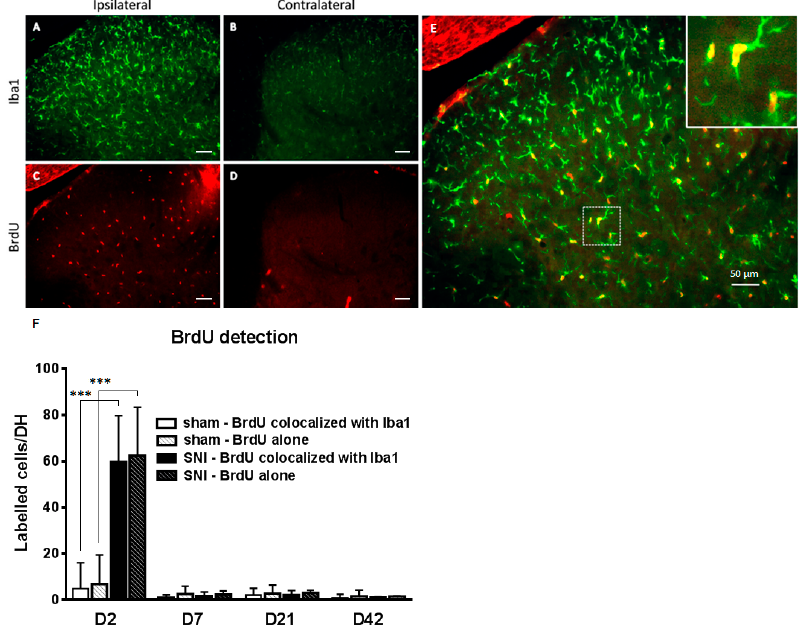
Figure 3. Colocalization of the proliferation marker BrdU with Iba1 in the ipsilateral dorsal horn two days after SNI. ( A – D ) Iba1 (green) and BrdU (red) in the ipsilateral ( A , C ) and contralateral ( B , D ) dorsal horn two days after SNI surgery. There is a marked microglial reaction on the ipsilateral side ( E ) Merge of Iba1 and BrdU ipsilateral showing the colocalization of the two markers indicating microglial proliferation following peripheral nerve injury. Insert: magnification ( F ) Time course of BrdU positive cells in dorsal horn, colocalized or not with Iba1. N = 4/group. Values are expressed as mean ± 95% CI, 2-way ANOVA with Sidak correction, *** p < 0.001. DH, dorsal horn. Scale bar represents 50 µm.